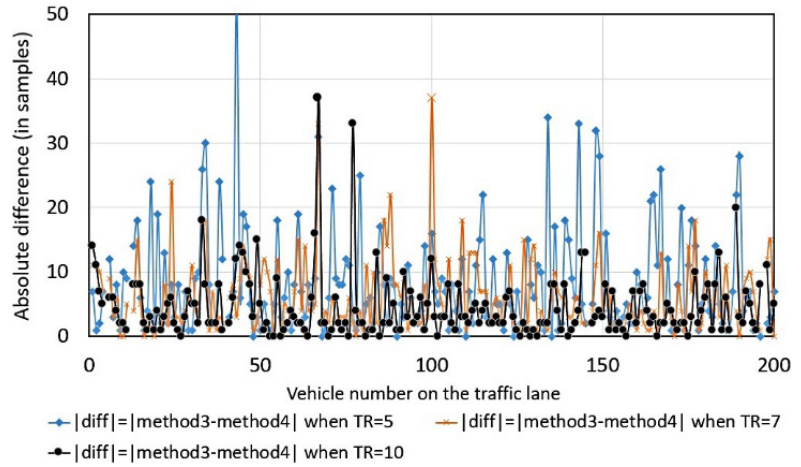
Figure 4 . The absolute differences between the estimated value from method 4 with reference to the value from method 3 using TR as a parameter, the magnitude of magnetic field data was used for the